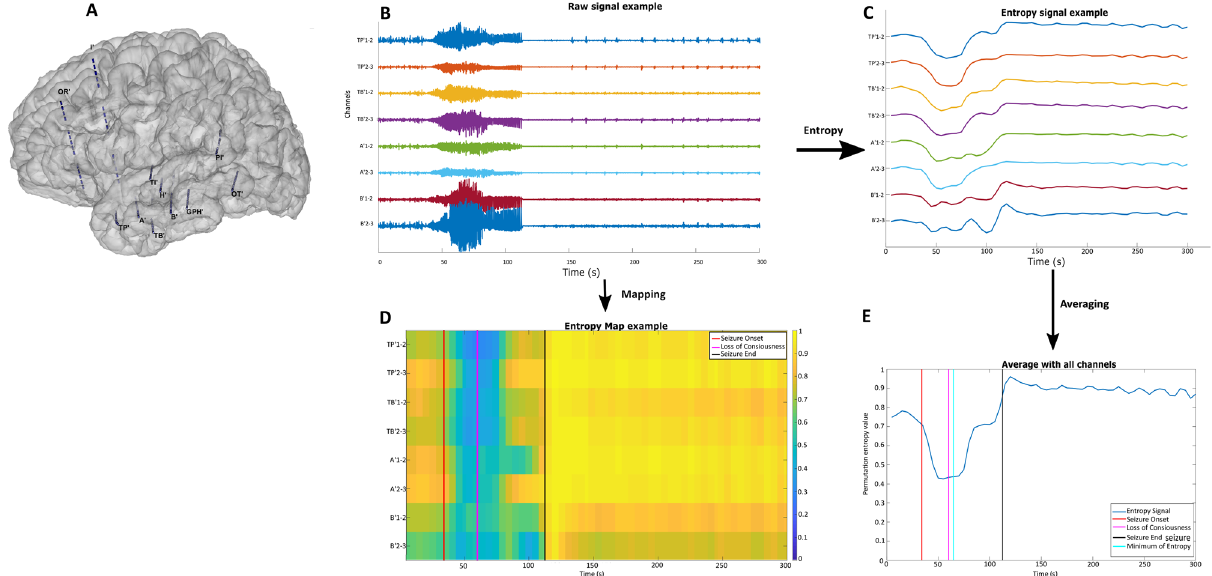
Figure 1. Illustration of the Permutation Entropy estimation. ( A ) 3D Representation of the stereotactic-EEG electrodes in one patient. ( B ) Electrophysiological signal associated to 8 different selected contacts of the implanted channels (bipolar montage). ( C ) Permutation entropy signal of those channels showing the decrease of values after seizure onset. ( D ) Map Representation of the entropy signal with the different markers, as set by the scorer, corresponding to the beginning of the seizure (red), the maximal loss of consciousness (pink) and the end of the seizure (black). ( E ) Average of the entropy signal of all the channels during a seizure with the following markers: Beginning of the seizure (red), Loss of consciousness (pink), minimum of entropy value (cyan) (this marker is used to determine the delta entropy) and the end of seizure (black). The red and black markers are determined by the scorer based on the electrophysiological signal; the pink marker is determined by the scorer based on the CSS; the cyan marker is determined in an automated way. Arrow means “after